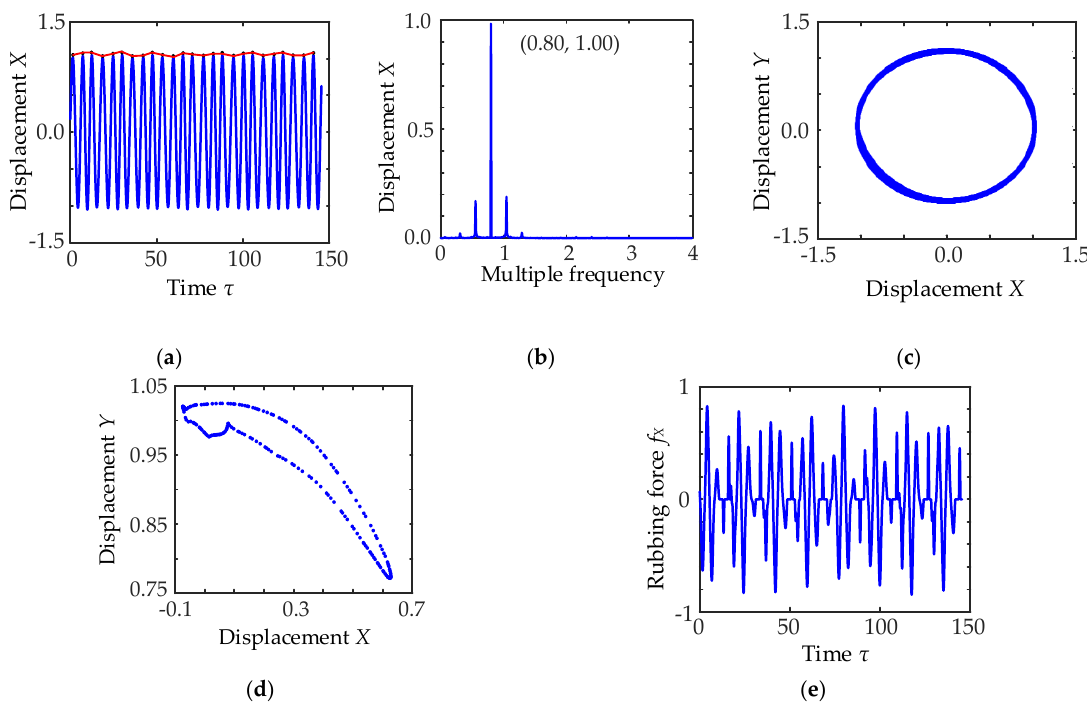
Figure 10. Rotor displacement when n = 10 krpm. ( a ) x - t ; ( b ) Amplitude spectrum; ( c ) Rotor trajectory; ( d ) Poincare mapping; ( e ) Rubbing force.